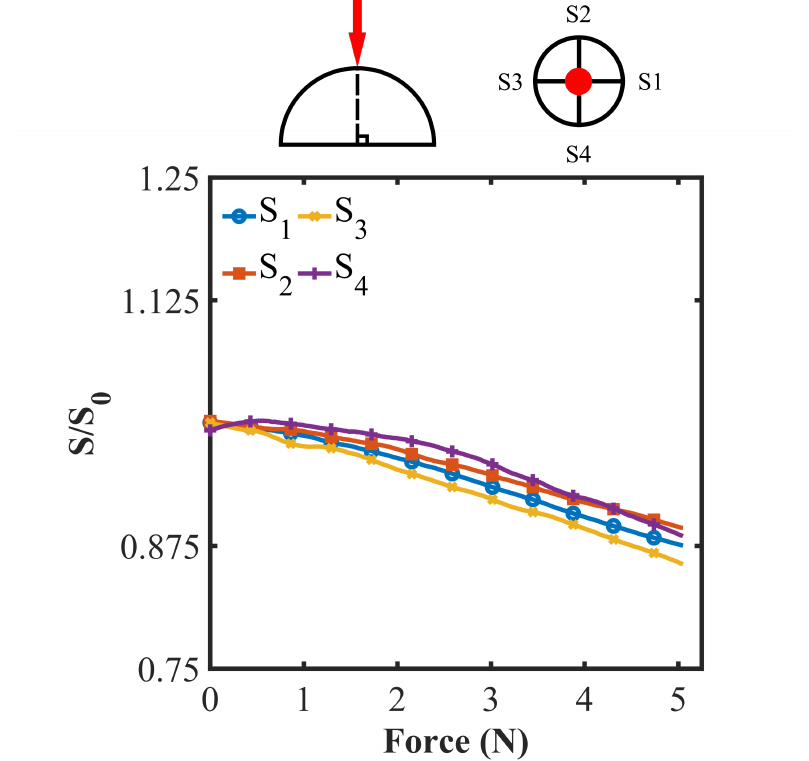
Figure 7. Force calibration against the normal force on the top of the hemispherical sensor; top view of the sensor system is illustrated and the red dot represents the applied (vertical) force direction into the